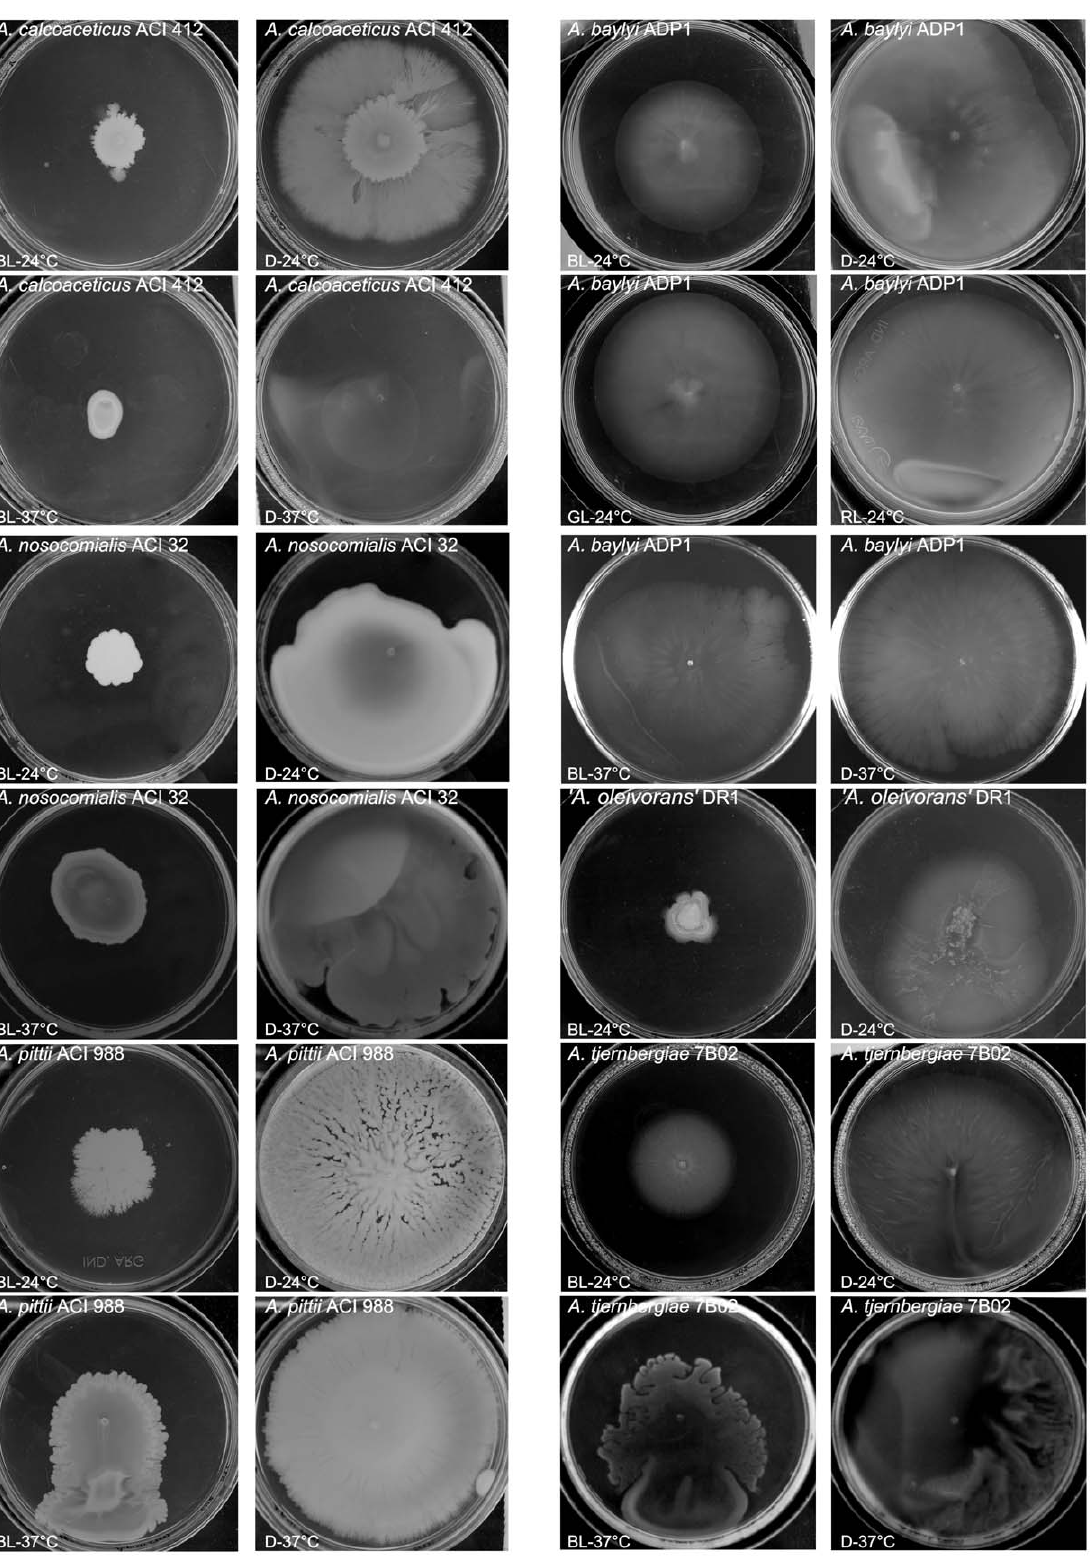
Figure 1. Effect of light and temperature on bacterial motility. Cells of different species within the genus Acinetobacter were inoculated on the surface of swimming plates. Plates were inspected and photographed after incubated overnight in darkness (D) or in the presence of blue light (BL), green light (GL) or red light (RL) at 24 u C or 37 u C. Only some strains displaying photoregulated motility are shown.